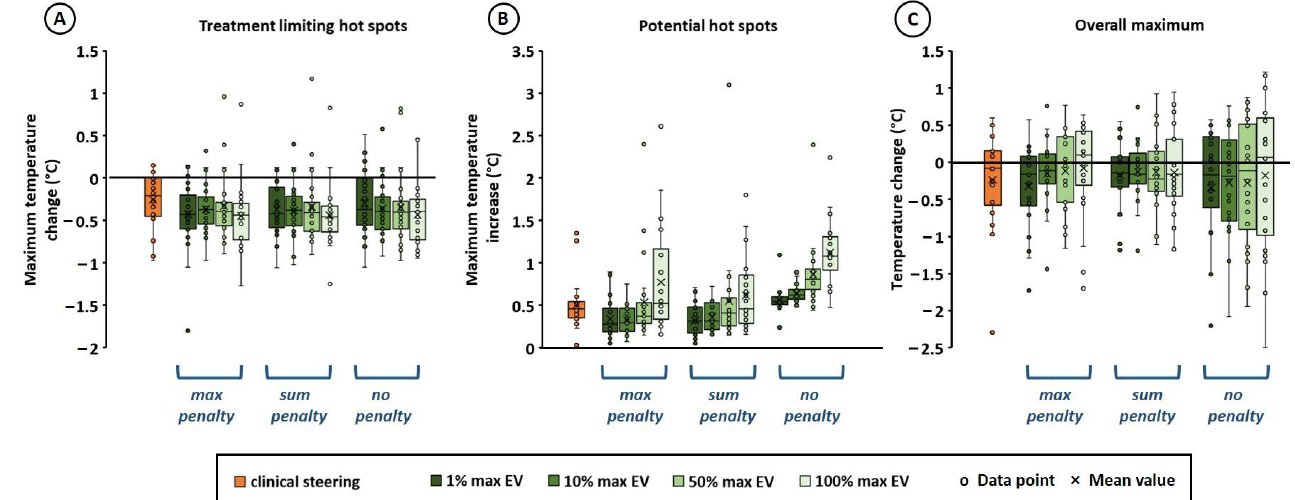
Figure 2. Effect of different re-optimization strategies on the predicted temperature at treatment limiting hot spot locations ( A ), other potential hot spot locations ( B ) and the overall maximum temperature ( C ). Results are compared to simulations for the clinically applied protocol/experience-based steering strategy during treatment. Max penalty, sum penalty and no penalty refer to the re-optimization goal functions in equations (3), (4) and (5), respectively. To efficiently calculate a hot spot temperature during optimization, the average temperature of the voxels with the x% largest heating potential was calculated, which are the voxels with the largest maximum eigenvalues (EV) of their temperature matrix ( T in equation (2). Values of x of 1, 10, 50 and 100% were evaluated. The hot spot diameter was 5 cm.